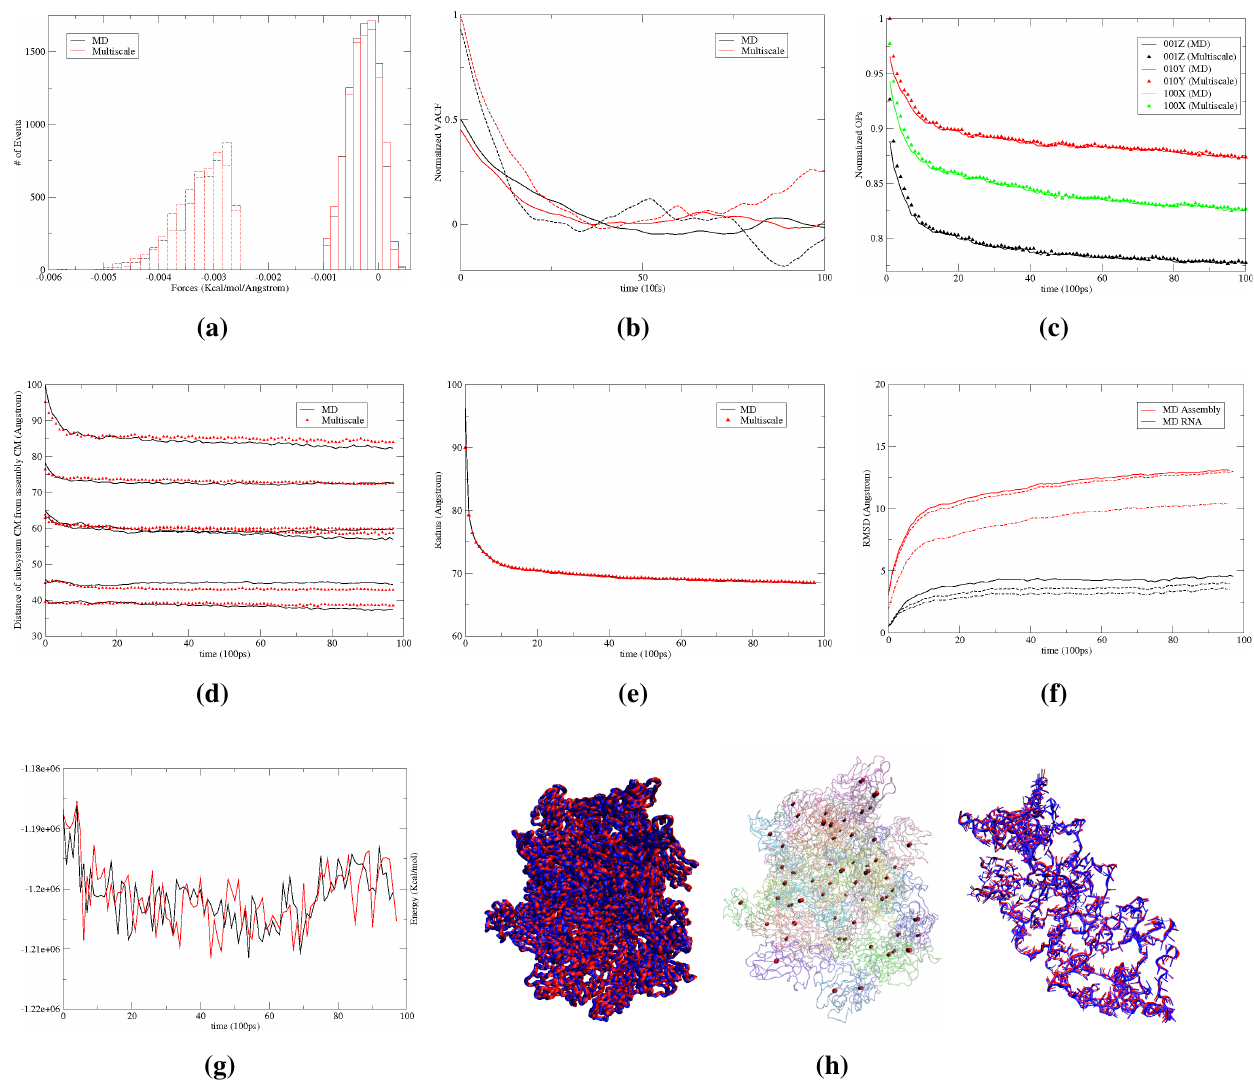
Figure 2. Distributions of the typical ( a ) subsystem center of mass (CM) (dotted) and OP ( Φ ) (solid) forces; and ( b ) the associated velocity autocorrelation functions from 100 X 10 ns MD and multiscale simulations of the satellite tobacco mosaic virus (STMV) protein-RNA assembly; ( c ) evolution of large-scale structural variables, including: global OPs, ( d ) subsystem CMs, ( e ) the radius of gyration and ( f ) the RMSD from the initial configuration. All numerical results show excellent agreement between MD and multiscale predictions. The RMSD from the initial structure also shows that the Langevin assembly simulation requires referencing to reproduce the MD results; however, capturing the RNA expansion does not require a dynamical reference structure. The dashed line implies the use of a dynamical reference structure, whereas dash-dots imply a fixed reference structure during the Langevin evolution of the system. ( g ) The potential energy profiles for the multiscale and MD simulations also show strong agreement; ( h ) visual comparison of multiscale (blue) and MD (red) generated all-atom structures of the assembled monomers and the RNA. Also provided are the positions of subsystem CMs in bead representation (multiscale (black) and MD (red)) showing almost identical